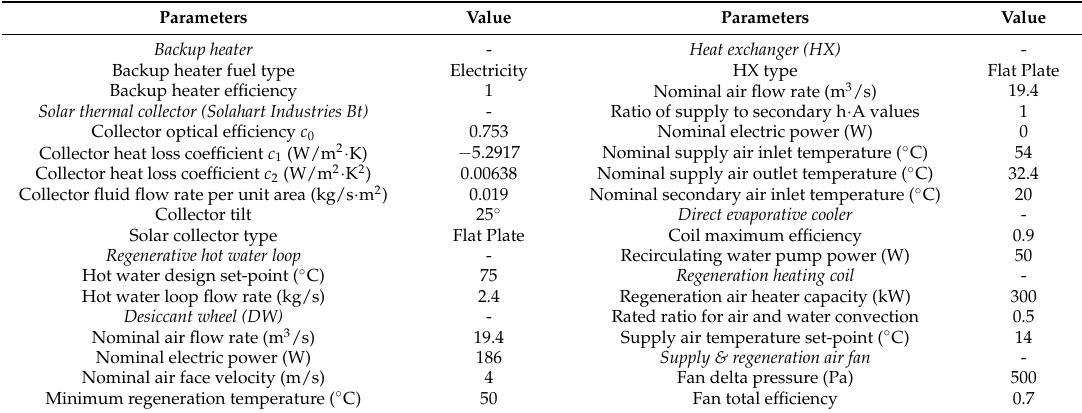
Table 4. General system input parameters in EnergyPlus simulation.